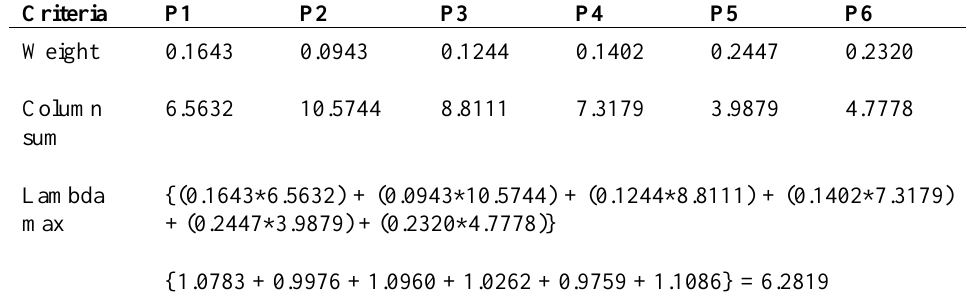
Table 5: Computation of Lambda Max of the Criteria with respect to Goal Criteria